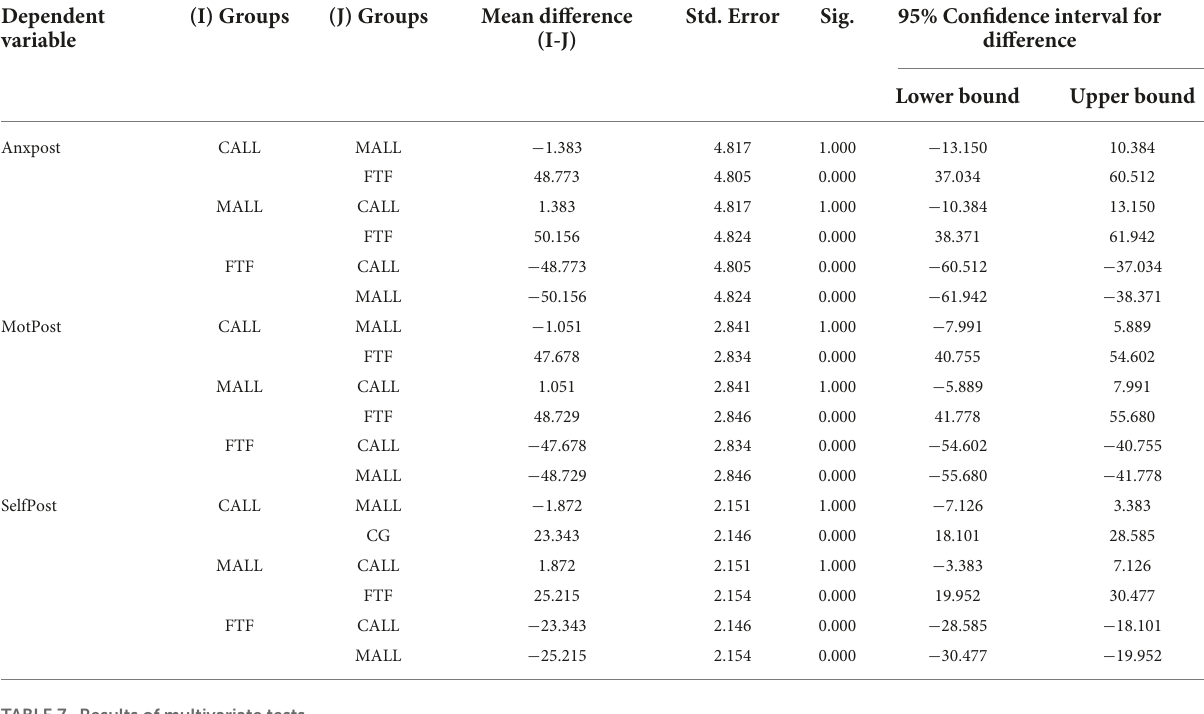
TABLE 6 Results of pairwise comparisons.